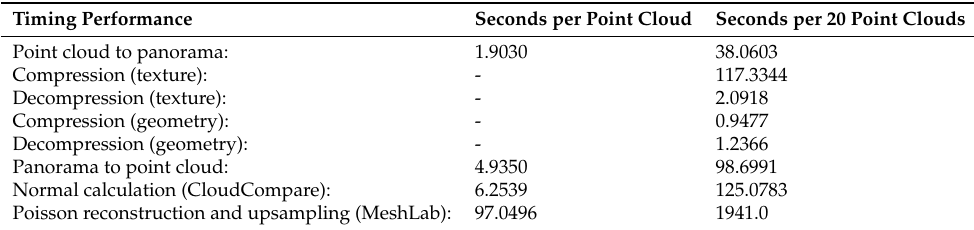
Table 10. Timing performance, for the Longdress point cloud and Miller 9-bit projection with panorama size of 2,000,000 points.